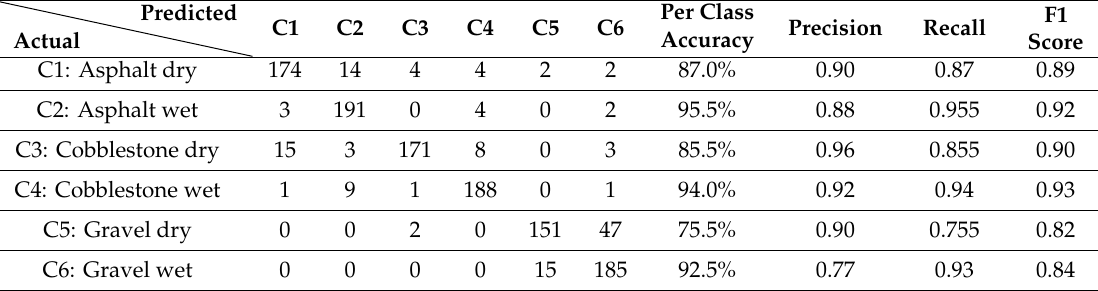
Table 2. Confusion matrix for road pavement type and condition combinations.